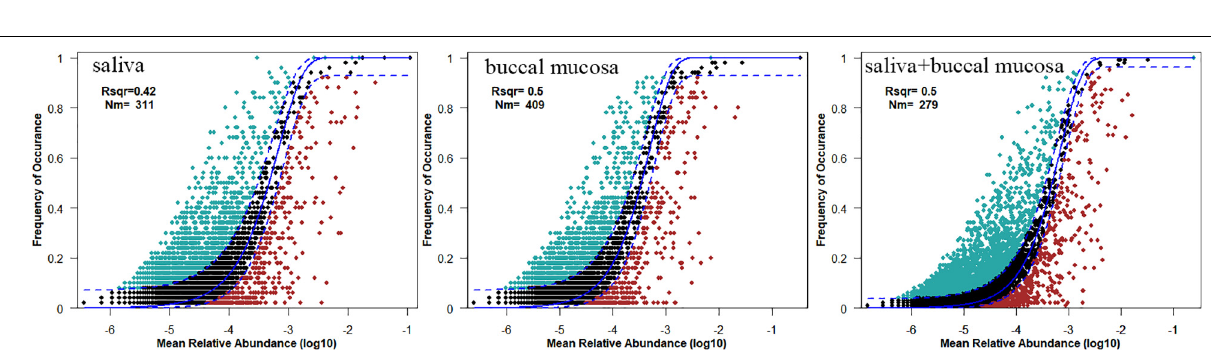
FIGURE 4 | The neutral community model of community assembly. The solid blue lines represented the fittest to the model, while the dashed blue lines represented 95% confidence intervals. Cyan, black, and red plots represented the occurrence frequency of OTUs above prediction, fit prediction, and below prediction, respectively. R 2 remarked the fitness of the neutral community